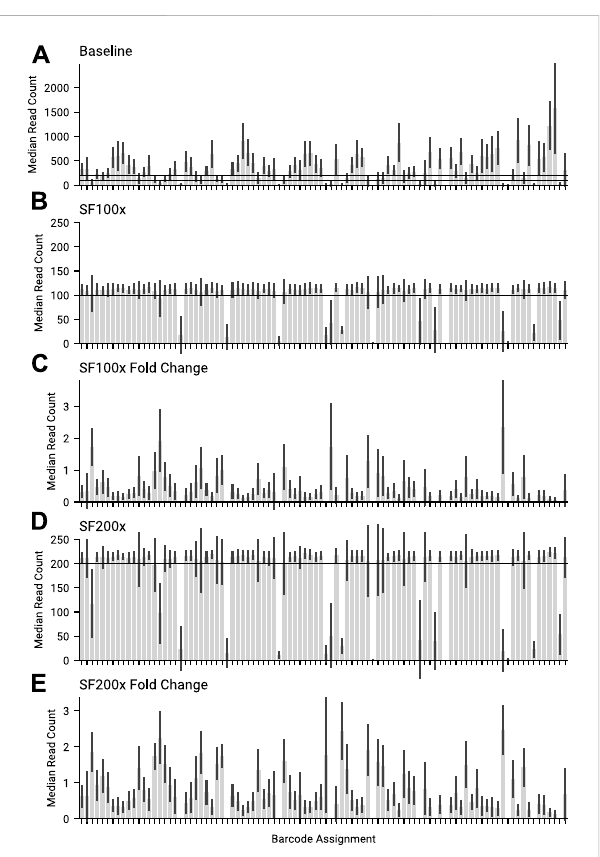
FIGURE 6 The median amplicon read count for each barcode, for the same library across different sword fi sh threshold targets. (A) Baseline, where no adaptivesamplingwasapplied.100and200aremarkedasthetargetsfor the other 2 experiments. (B) SF100 had a 100× coverage sword fi sh threshold target. 100× is marked on the graph. (C) Fold change for